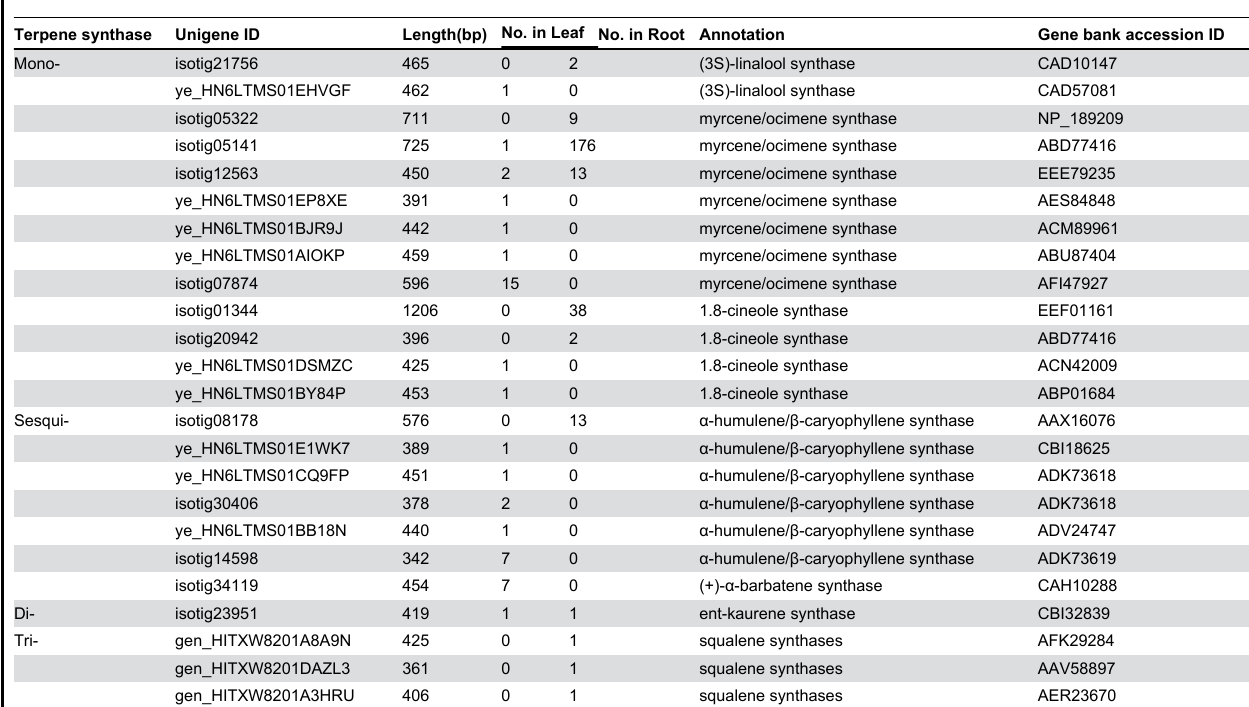
Terpene synthase Unigene ID Length(bp) No. in Leaf No. in Root Annotation